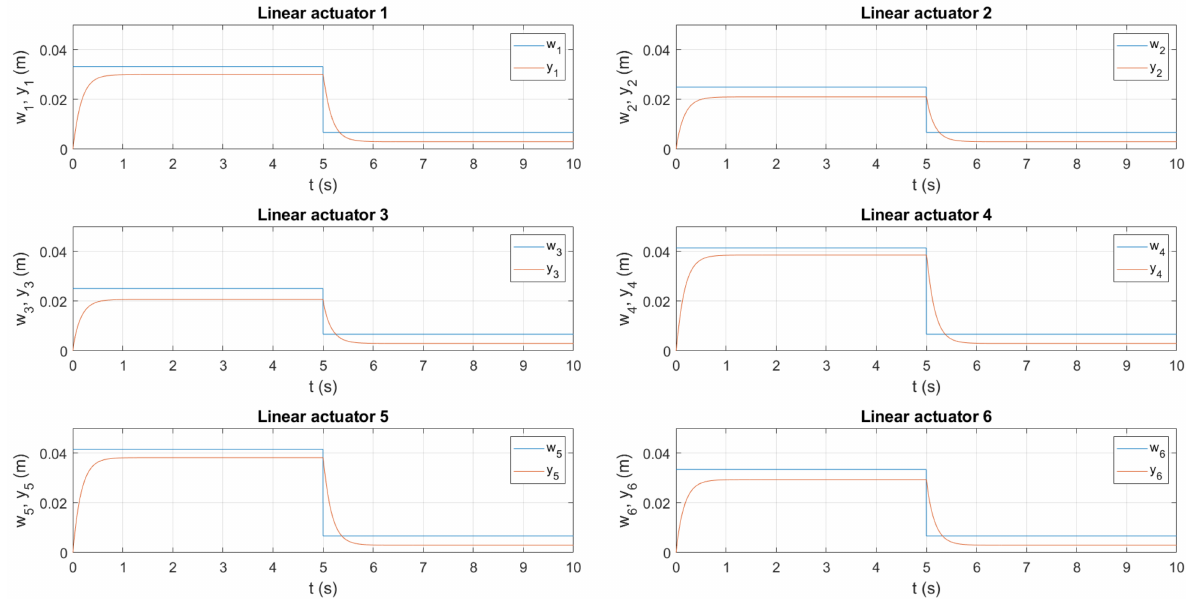
Figure 9. Actual and desired piston rod extensions of the Stewart platform linear actuators (MiL).